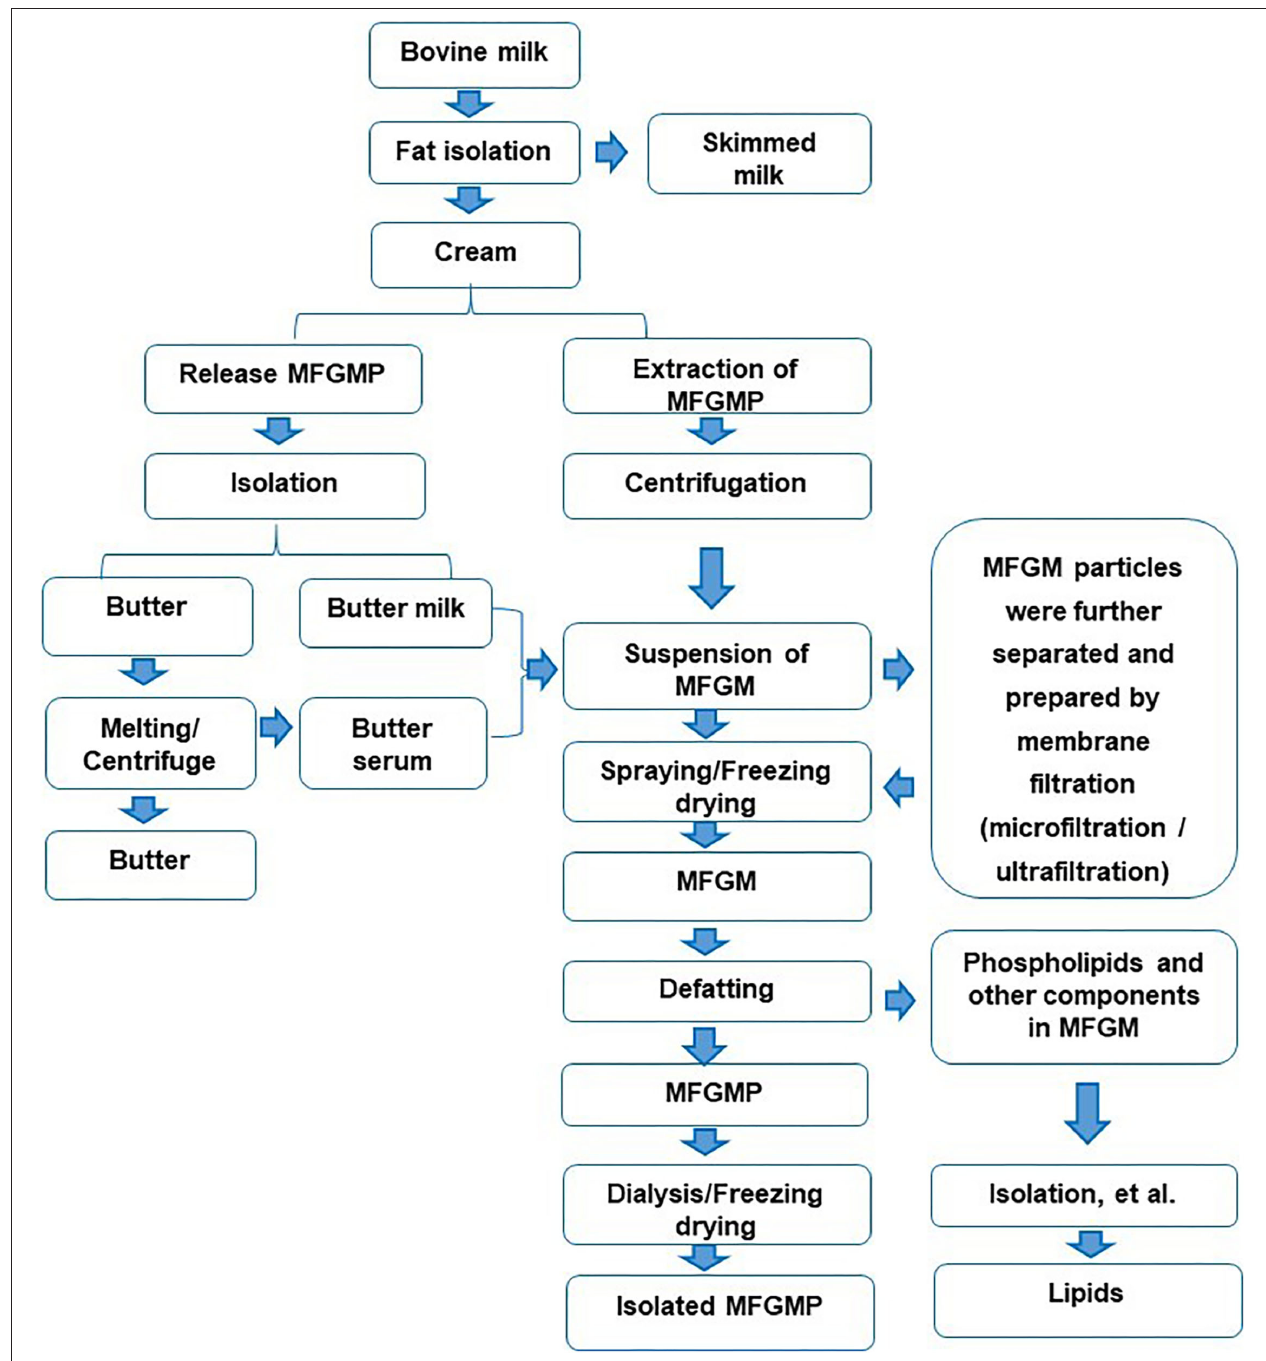
FIGURE 1 | Isolation and separation of the components in Milk fat globule membrane (MFGM) from bovine milk.